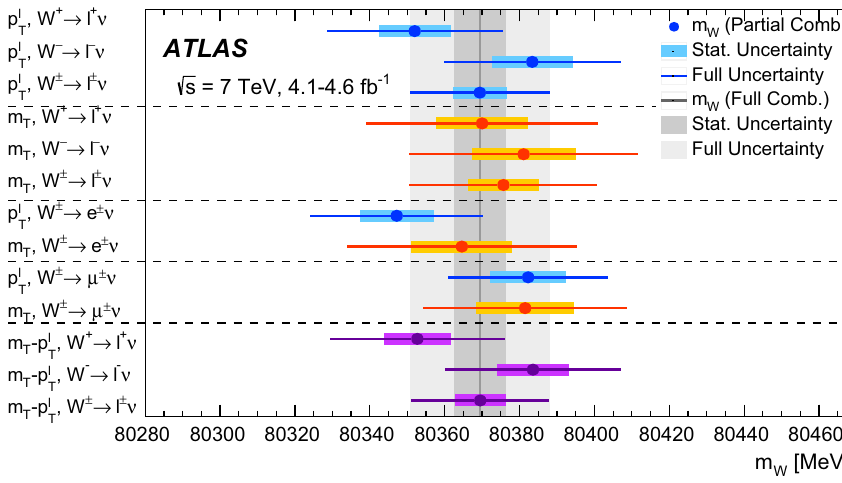
Fig. 26 Overview of the m W determinations from the p (cid:7) and T m T distributions, and for the combination of the p (cid:7) and m T T distributions, in the muon and electron decay channels and for W + and W − events. The horizontal lines and bands show the statistical and total uncertainties of the individual m W determinations. The combined result for m W and its statistical and total uncertainties are also indicated (vertical line and